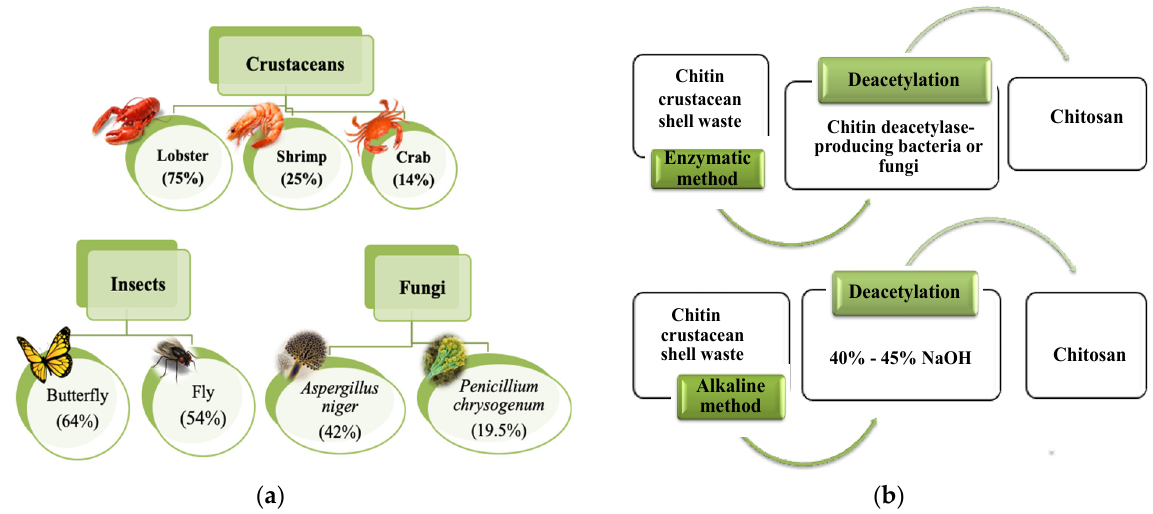
Figure 1. ( a ) Examples of chitin content from different sources, ( b ) Chitin deacetylation methods to produce chitosan.